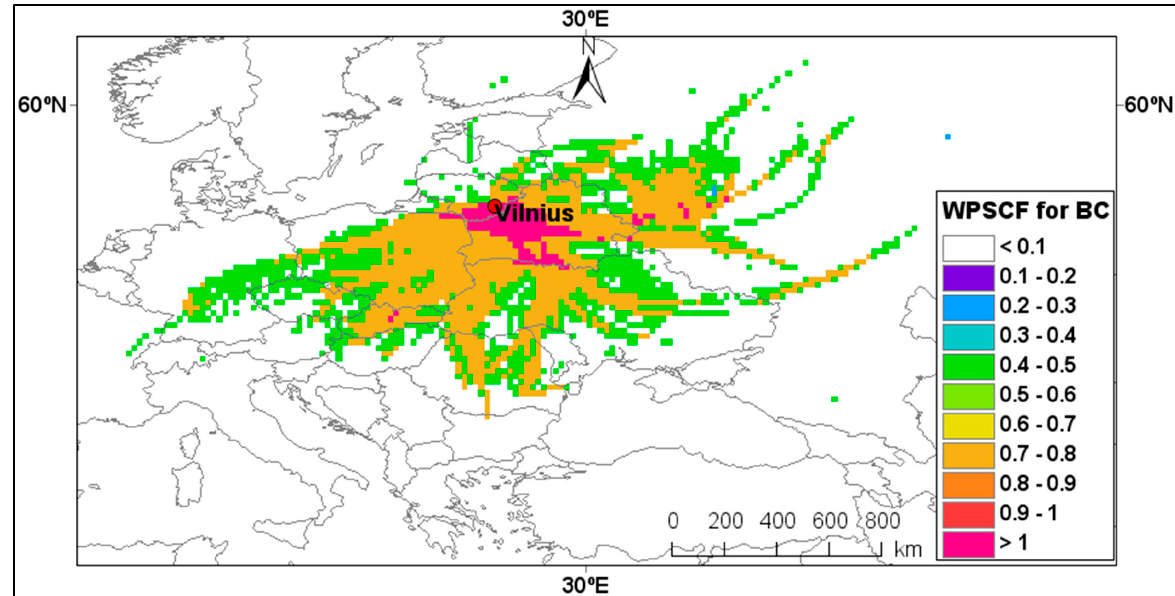
Figure 9. Weighted potential source contribution function of BC in Vilnius in January and February 2014.